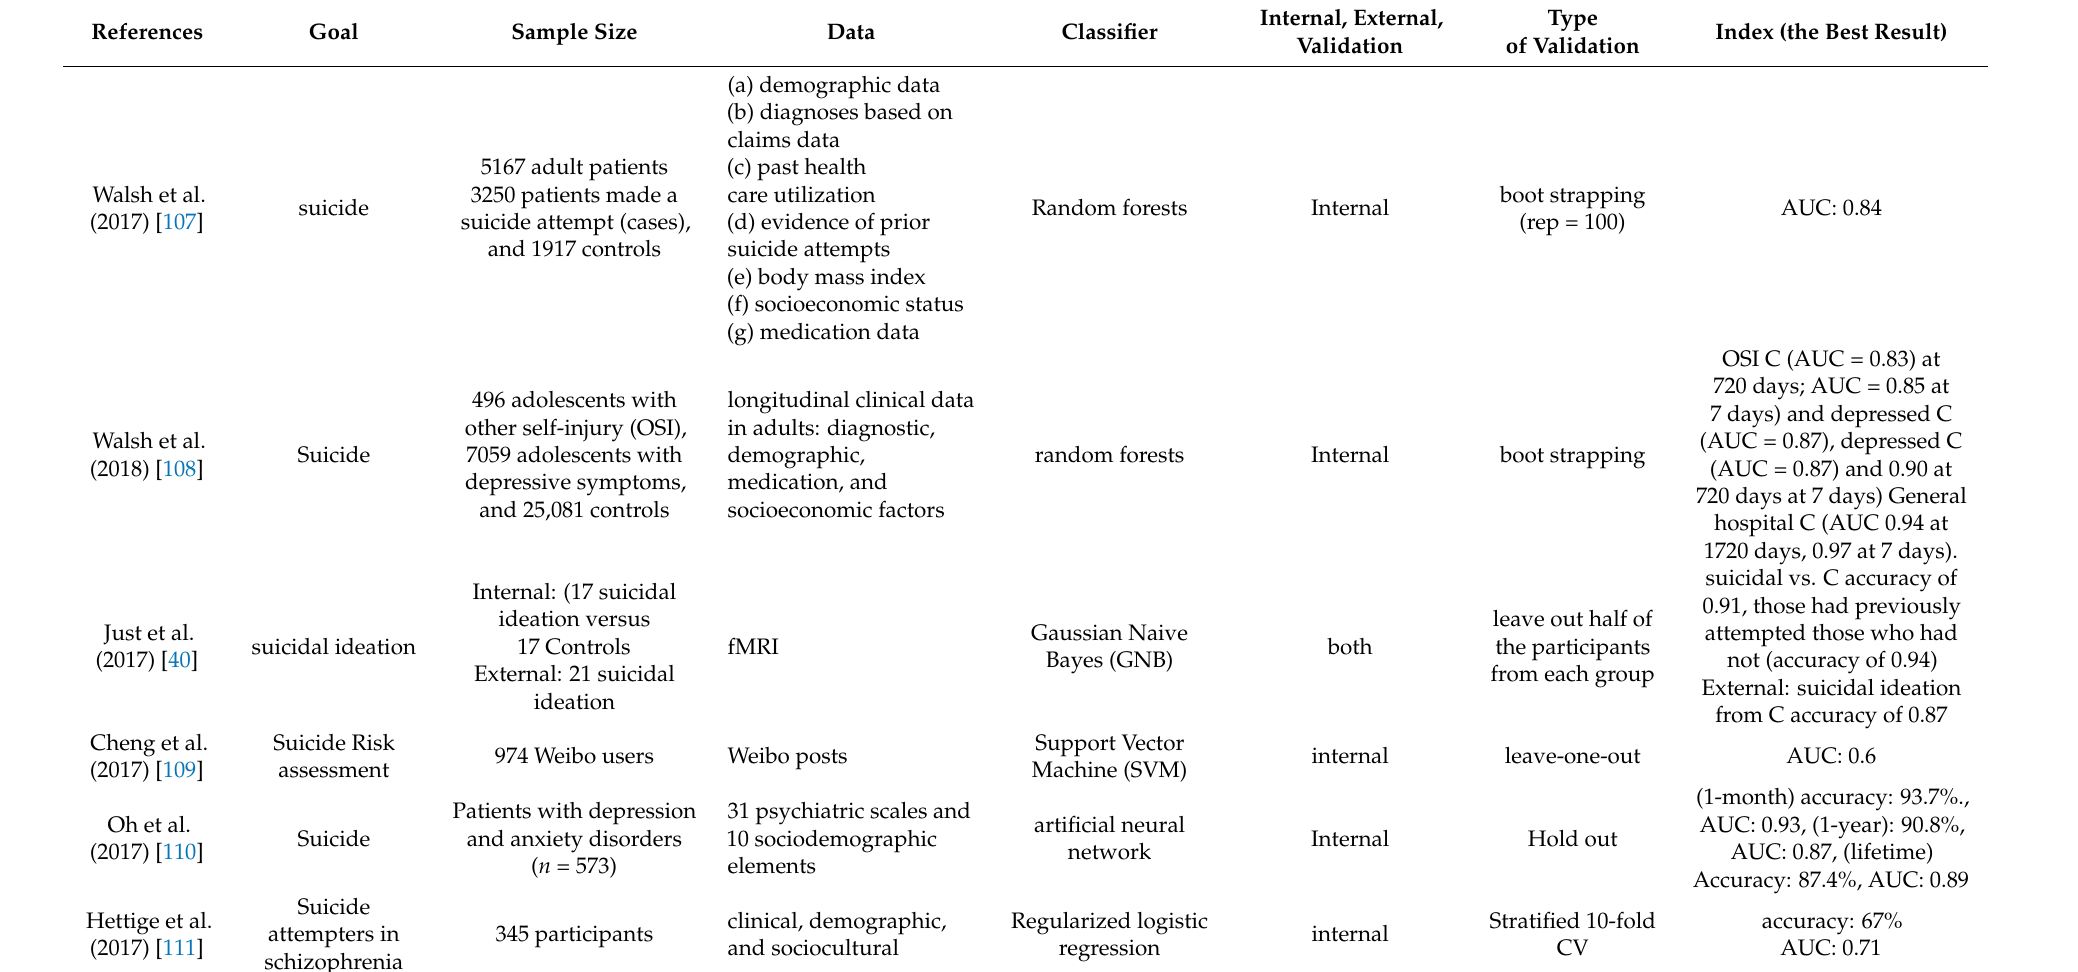
Table 8. CAD methods for suicide